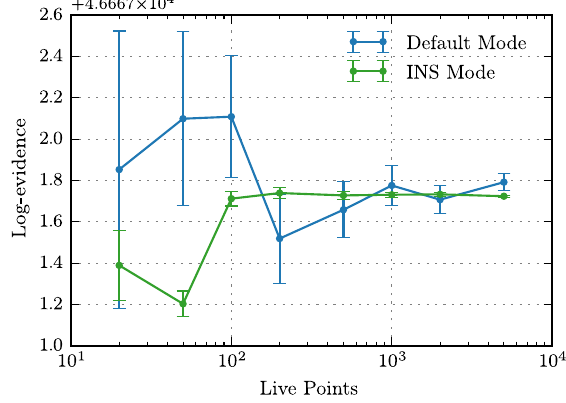
The resulting distributions of log-evidence are shown in Fig. 19. The dashed error bars show the averaged (cid:4) 1 σ intervals reported by MultiNest , while the solid bars show the (cid:4) 1 σ intervals obtained manually from the distributions. We see that the errors reported by MultiNest ’ s default mode appear to accurately reflect